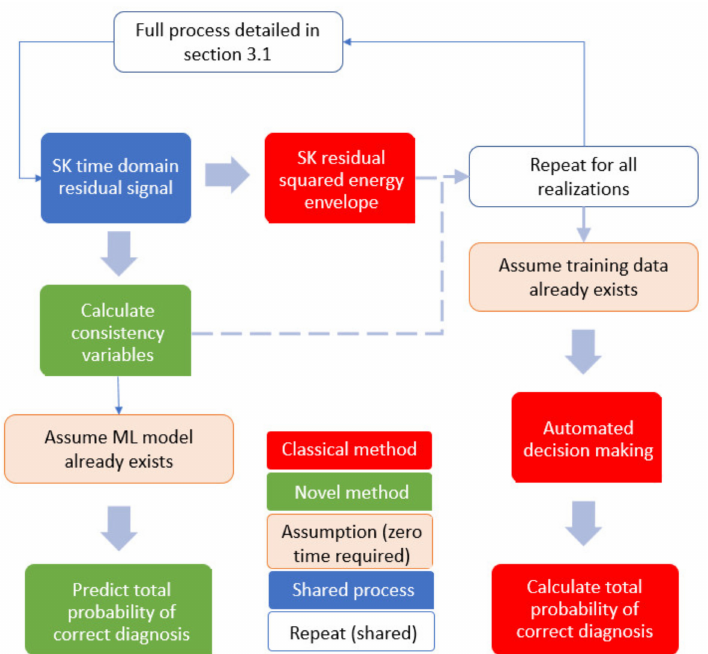
Figure 17. Flowchart to visualise the different estimation steps between the traditional and the novel methodologies.